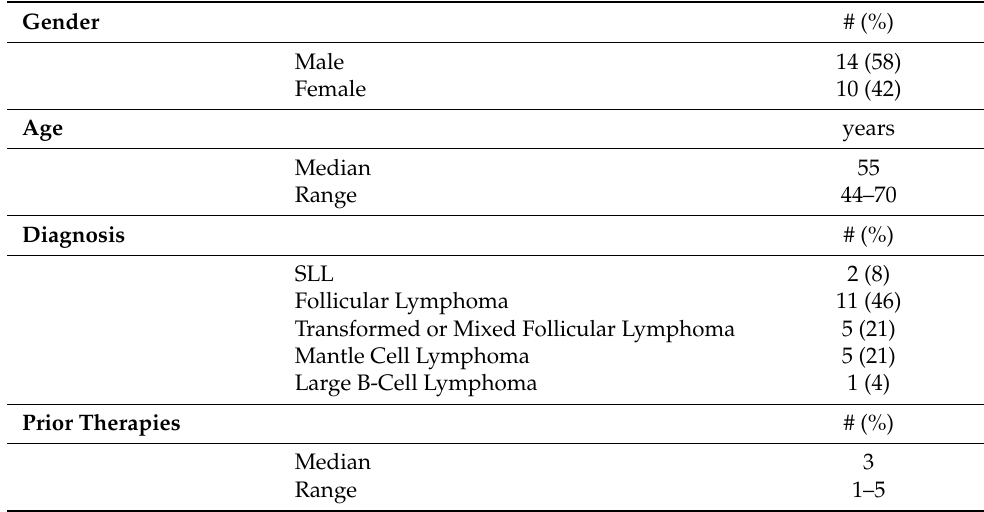
Table 1. Patient population and key demographic considerations. # =